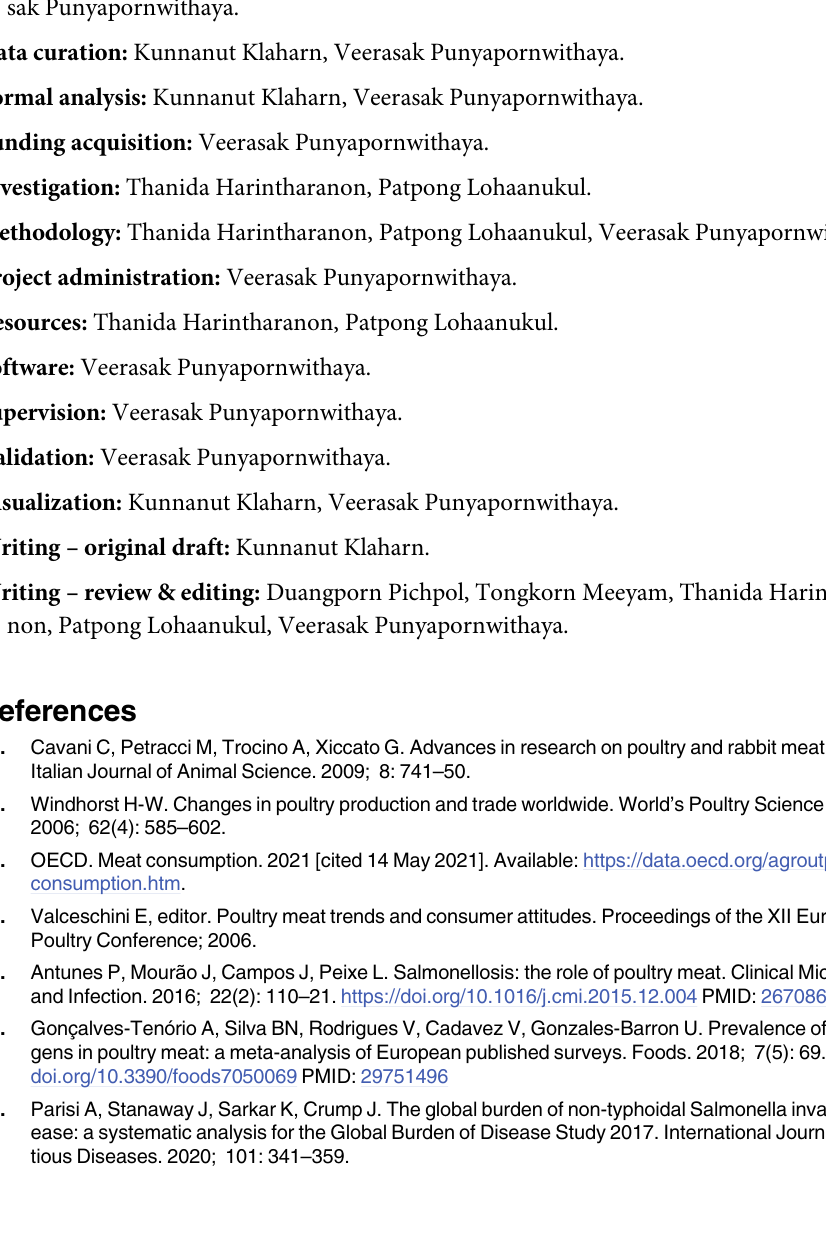
S2 Table. Factors used for the mixed-effects logistic regression